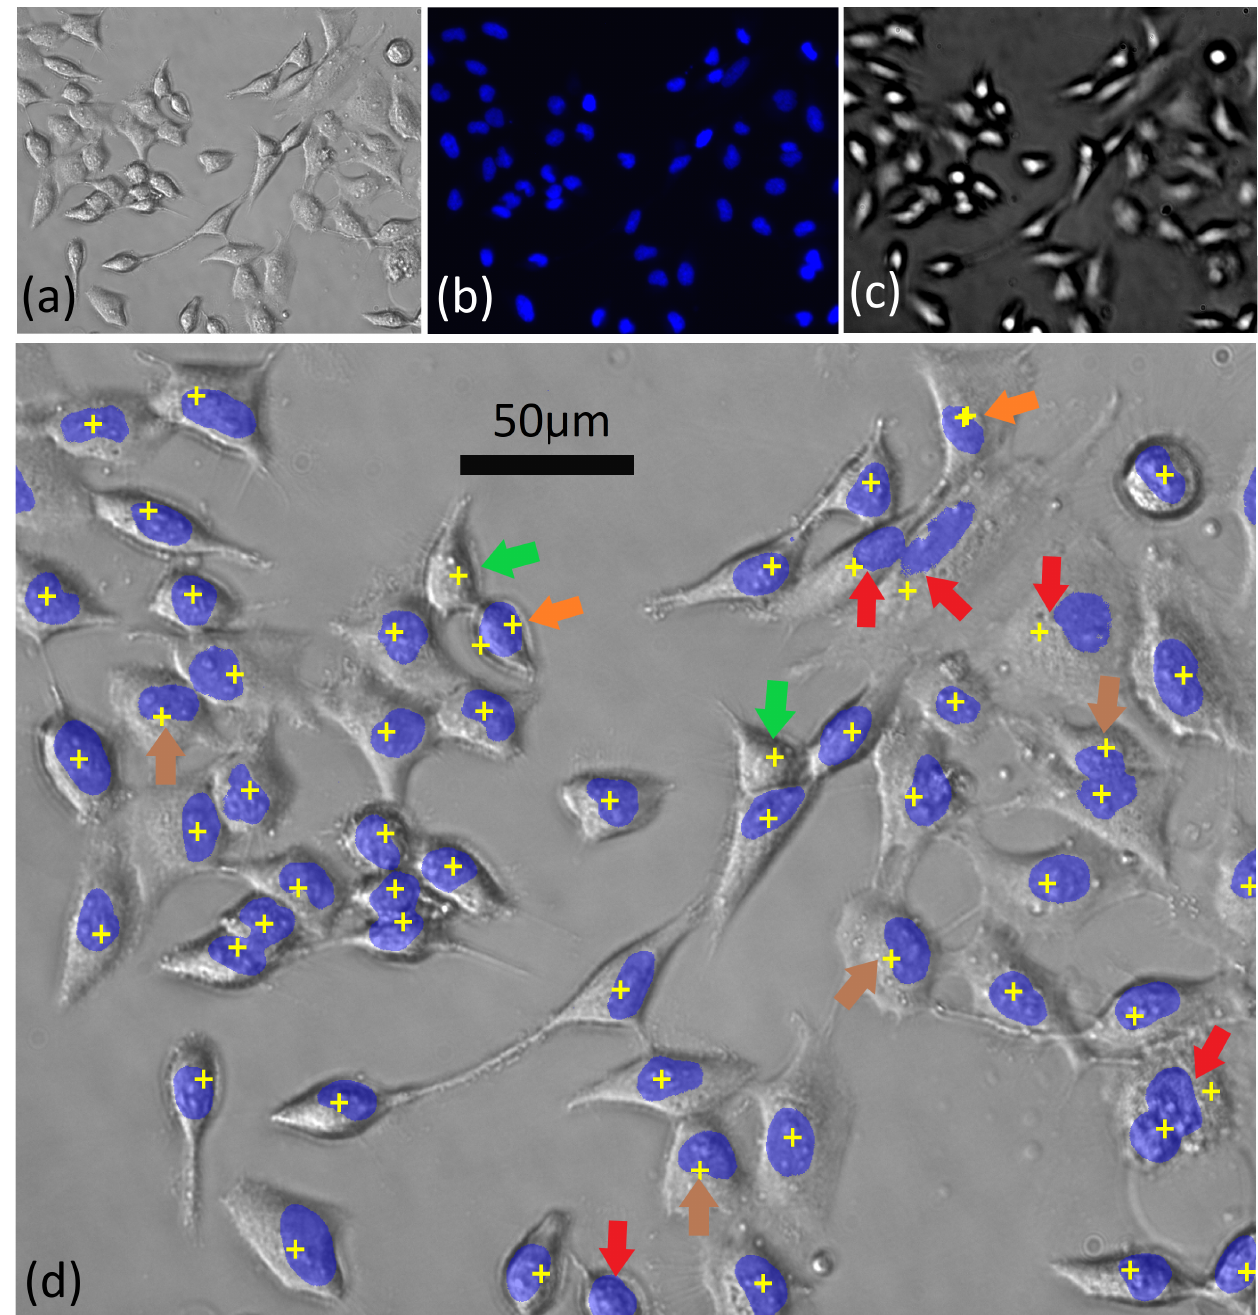
Figure 1. Live HeLa cells in medium: ( a ) bright-field image; ( b ) fluorescence image using DAPI; ( c ) bright-spot image: sample at 50 µ m from focal plane; ( d ) combined images. Images ( a , b ) are superimposed together with the positions of the local maxima in image ( c ) following image processing. The arrows are described in the